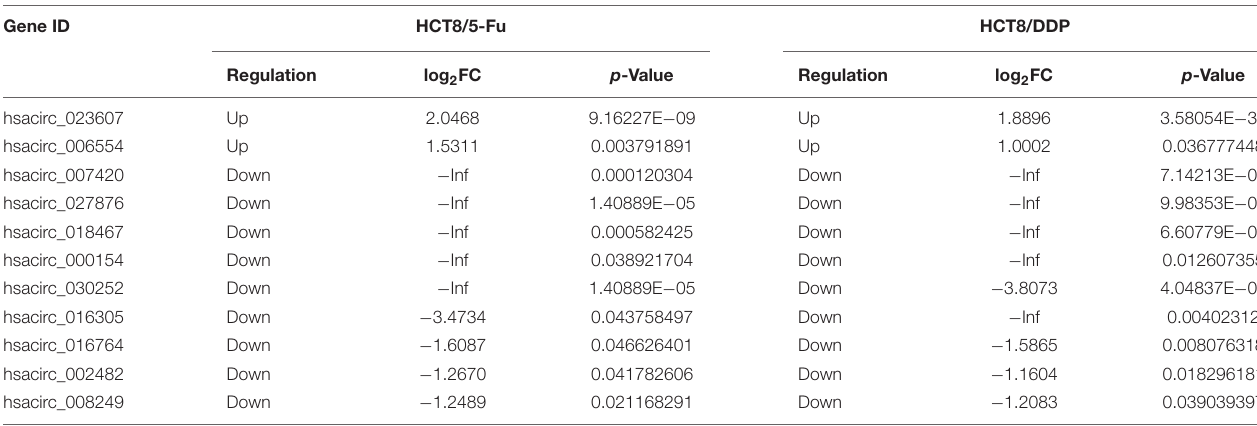
TABLE 2 | Common DE-circRNAs in chemoresistant cell